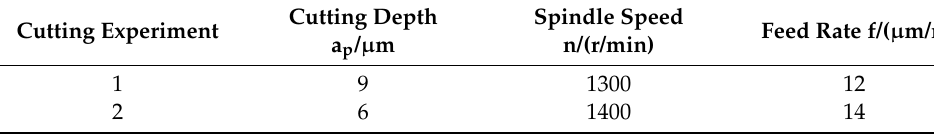
Table 2. Cutting parameters used in the